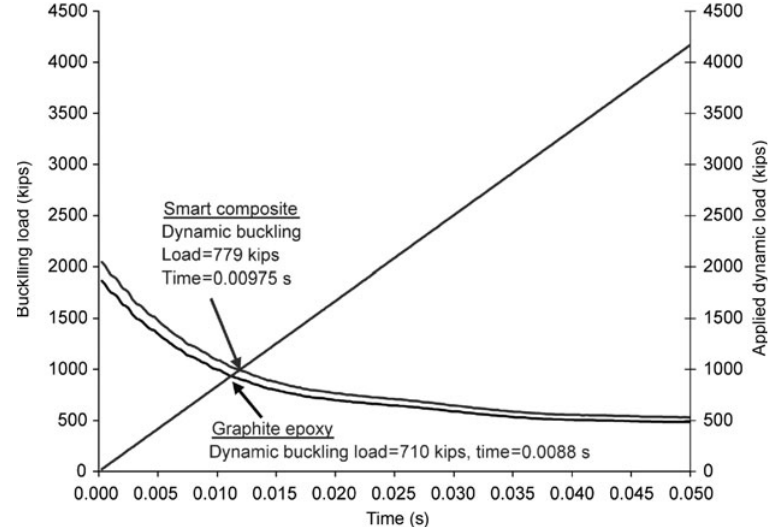
Figure 9 Dynamic buckling load of graphite epoxy and smart composite shells at 0.001 probability. (1 kip = 4.45